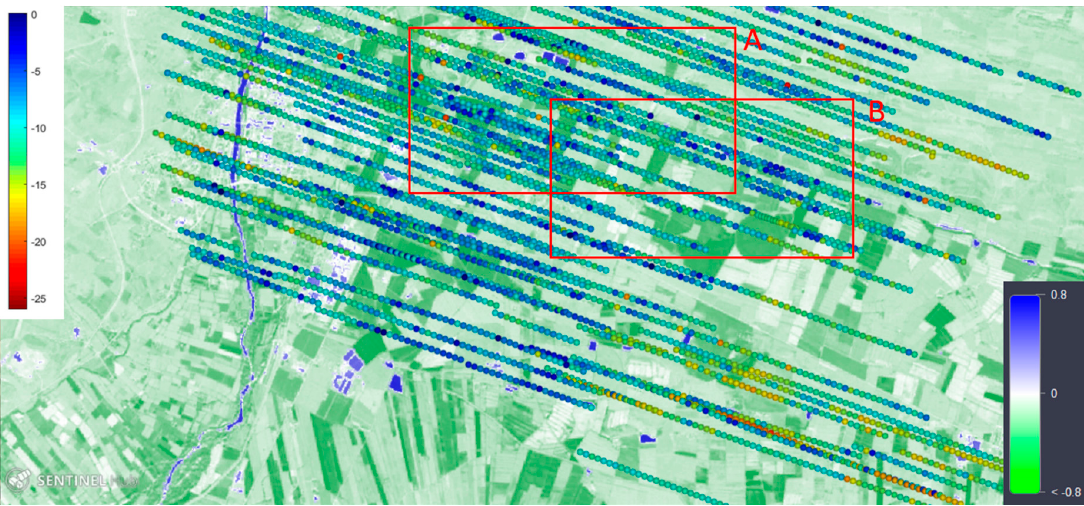
Figure 10. Sentinel-2 L1C Normalized Difference Water Index (NDWI) for October 23rd, 2018, and CORTO GNSS-R reflectivities. Red rectangles correspond to regions in Figure 8.